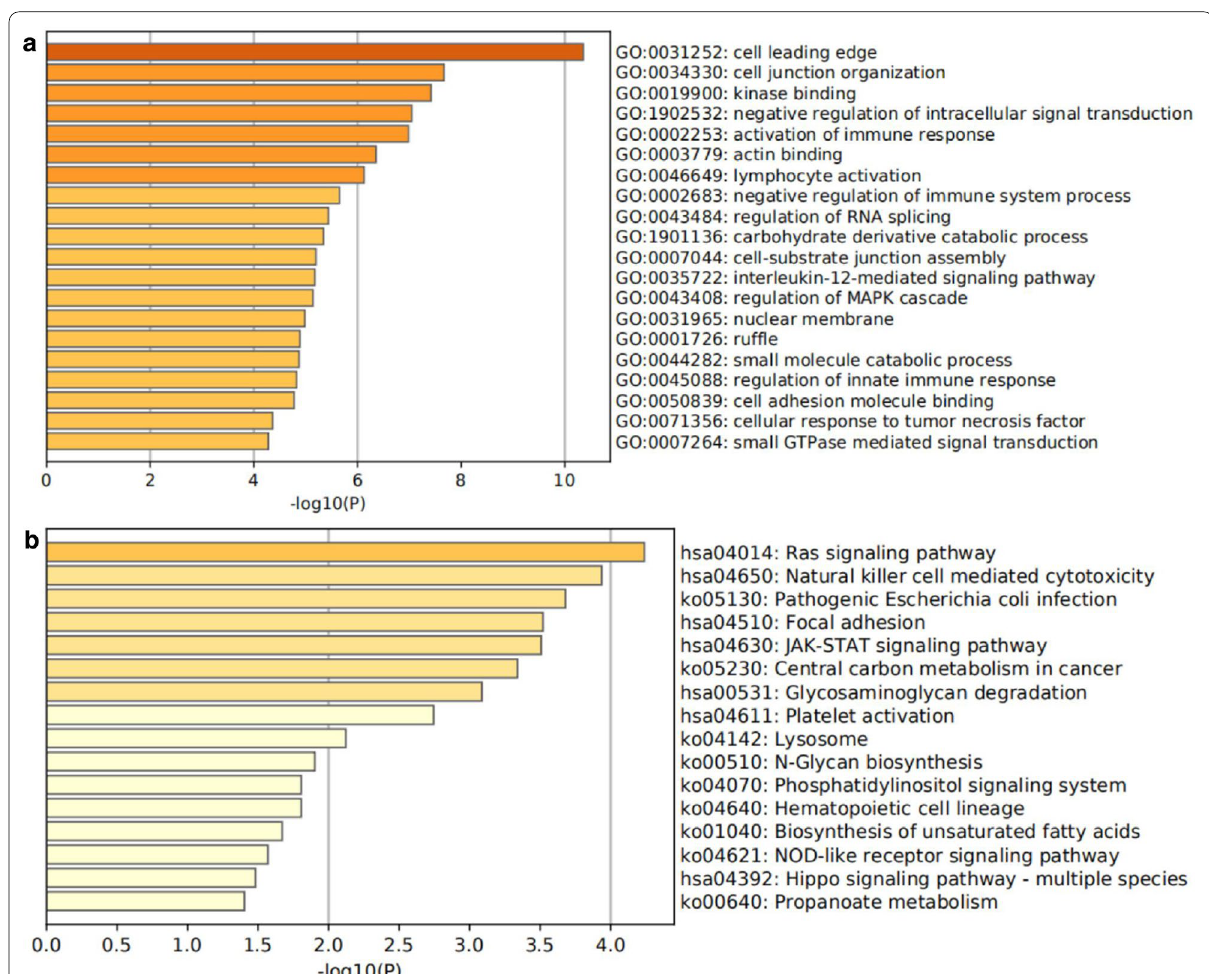
Fig. 5 Enrichment analyses of the DEASs. a Bar graph of the top 20 results from the GO enrichment analysis. b Bar graph of the top 16 results from the KEGG enrichment